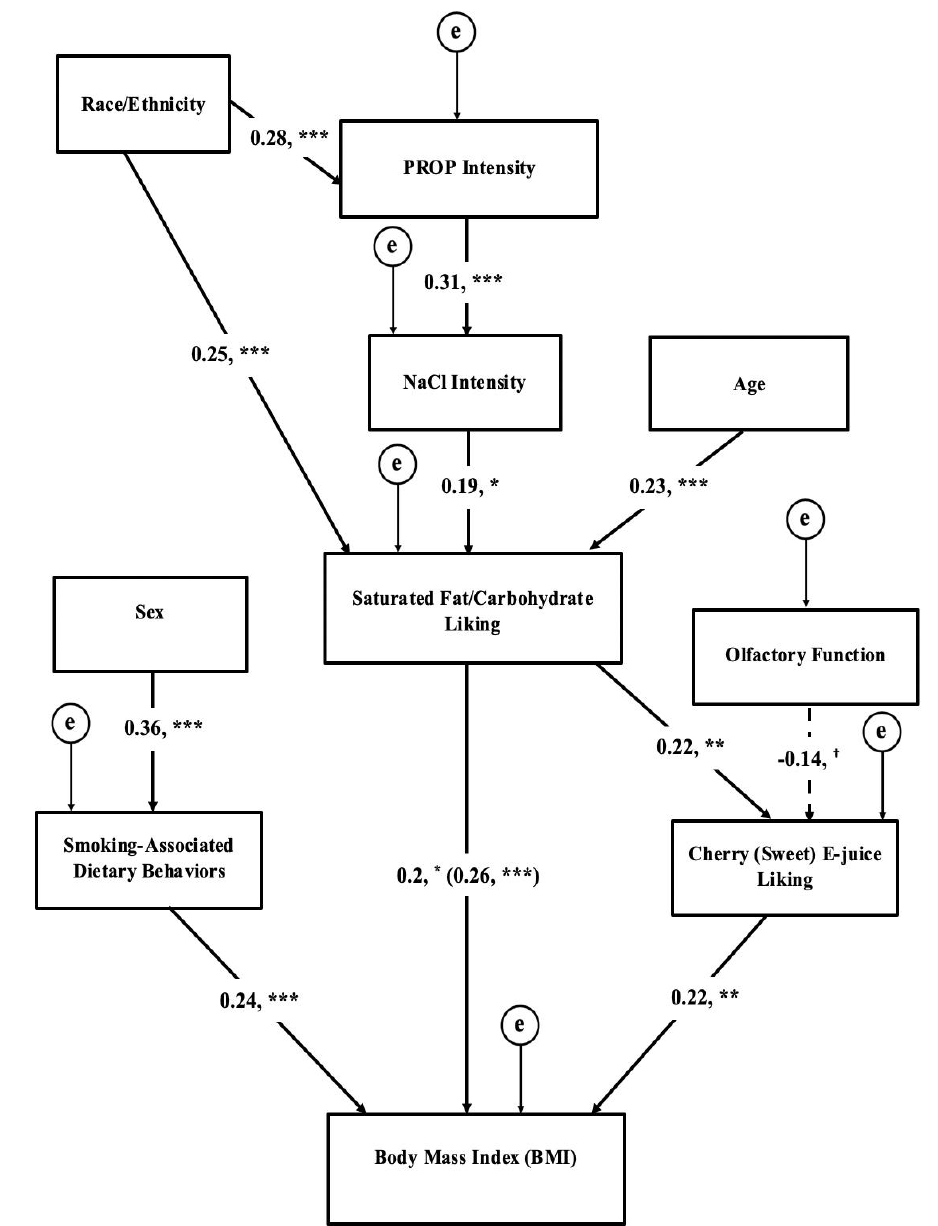
Figure 2. Structural equation model testing direct and indirect associations between taste, liking, smoking-associated dietary behaviors, and BMI in chronic adult smokers. Errors (represented by the encircled letter “e”) are required computationally, but are not of theoretical interest. The coefficient in parenthesis represents the associations before cherry e-juice liking was added to the model indicating cherry e-juice partially mediated the dietary preference-BMI relationship (indirect effect coefficient = 0.05, p < 0.05). With all non-significant pathways removed, the model remained an adequate fit (CFI = 1.00, TLI = 1.00, Chi-square = 34, df = 34, p = 0.47, RMSEA = 0.00, 90% C.I. 0.000–0.063). *** indicates that p ≤ 0.005; ** p ≤ 0.01; * p ≤ 0.05; † p ≤ 0.1. (PROP= 6-n-propylthiouracil).